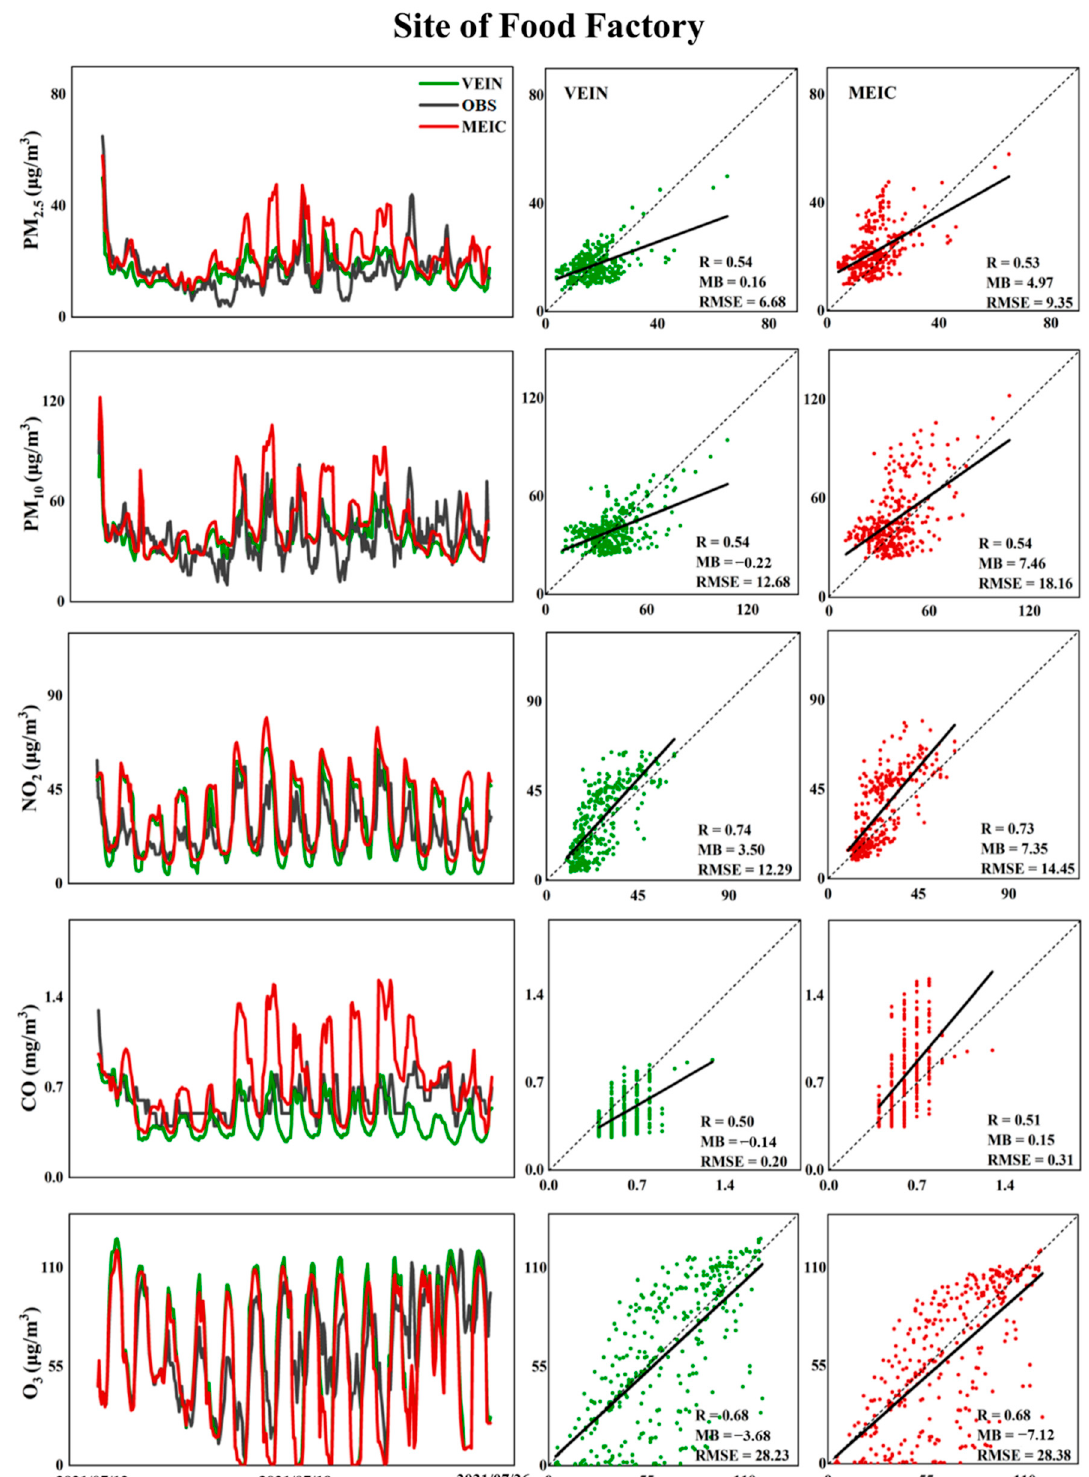
Figure 4. Comparisons between simulations with/without updated traffic emissions and observations of various pollutants with statistical metrics at the site of Food Factory from 12 July to 25 July.